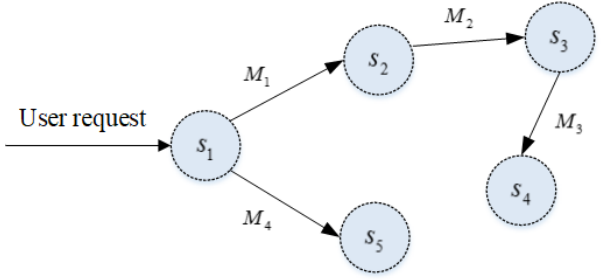
Figure 1. An application model based on micro- services